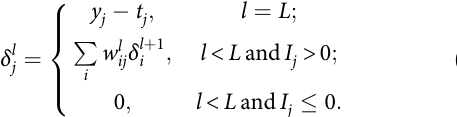
algorithm fl ow chart, Supplementary Fig. 6 for a uni fi ed modeling language class diagram, and Supplementary Fig. 5b, c for a